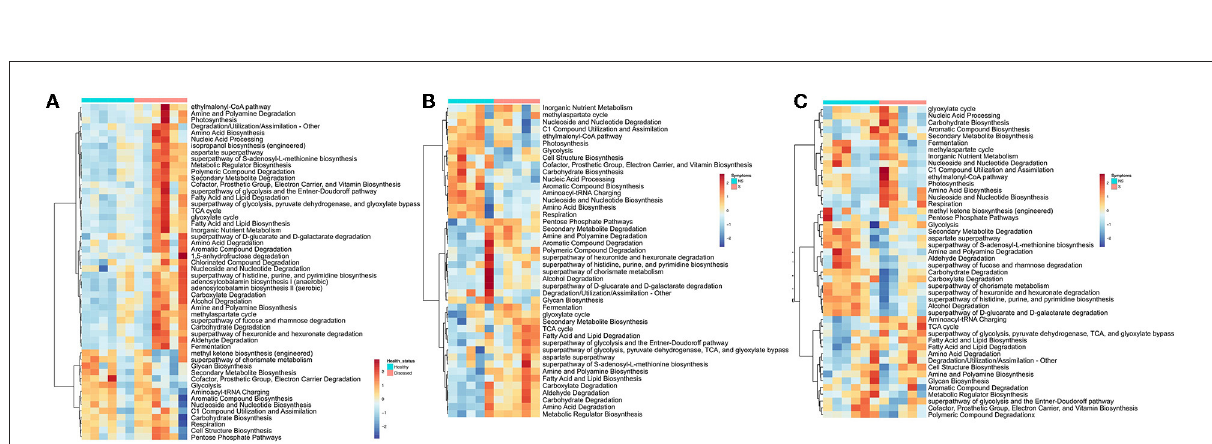
FIGURE3 Heatmap Clustering the relative abundance of functional signatures of bacterial microbiome of rice from (A) the rhizosphere, (B) leaf, and (C) grain samples as predicted by Phylogenetic Investigation of Communities by Reconstruction of Unobserved States (PICRUSt2) within Meta-Cyc categories. S and NS represent symptomatic and non-symptomatic tissues,